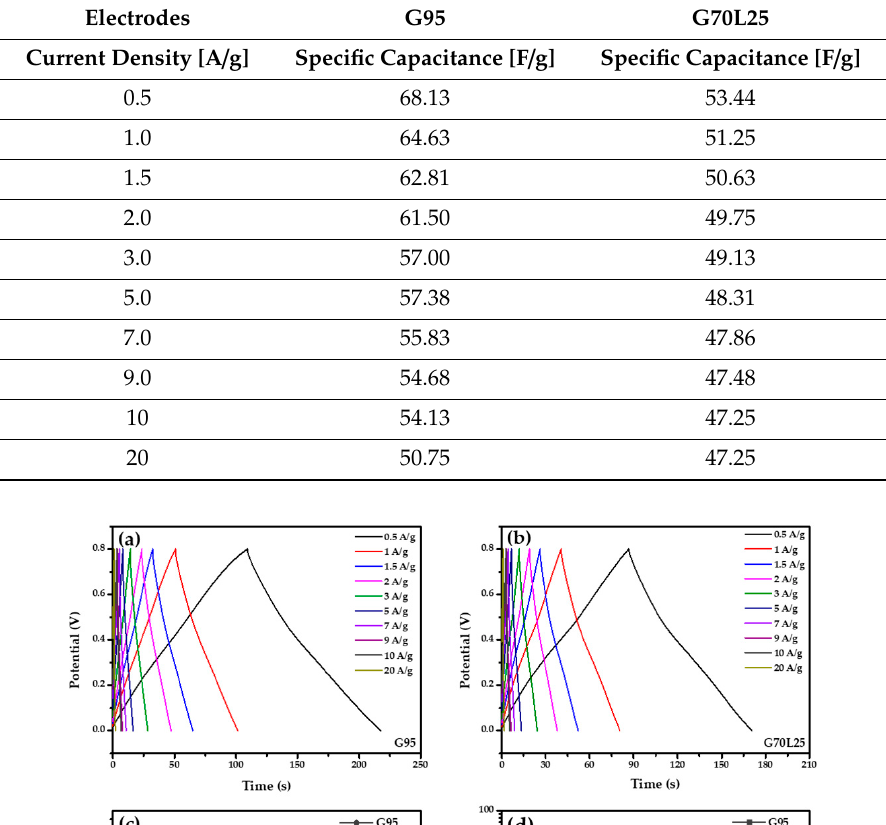
Table 1. The specific capacitance of G95 and G70L25 according to current density.